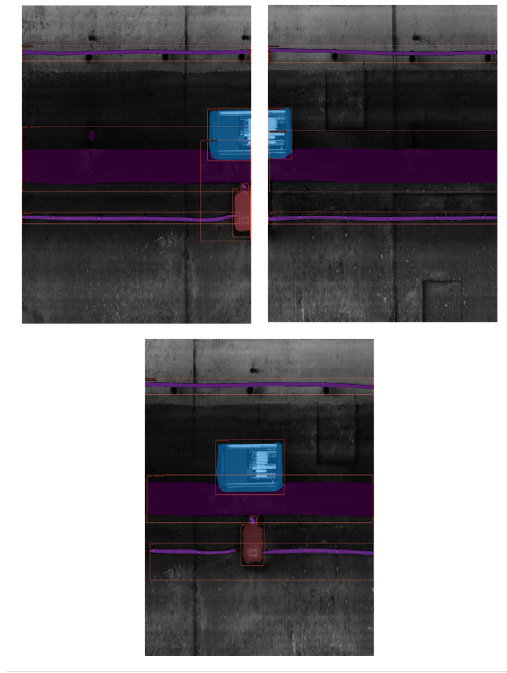
Figure 7. Results obtained on two contiguous images (top) and on their “in-between” image